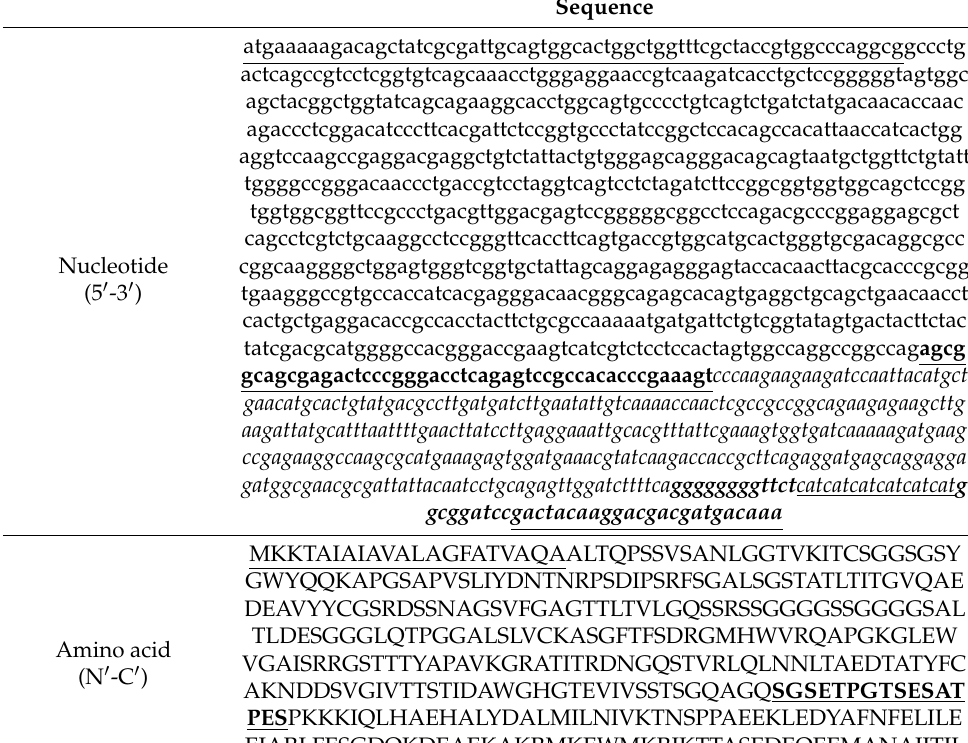
Table 1. Nucleotide and amino acid sequences of Neo2/15-conjugated anti-PDL1 scFv with tags. Underline: OmpA signal peptide, normal text: anti-PDL1 scFv, underlined bold: XTEN linker, italic: Neo2/15, bold italic: GS linker, underlined italic: His-tag, underlined bold italic: